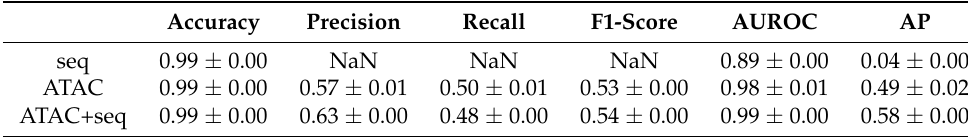
Table 4. HepG2 cell line training–evaluation results.